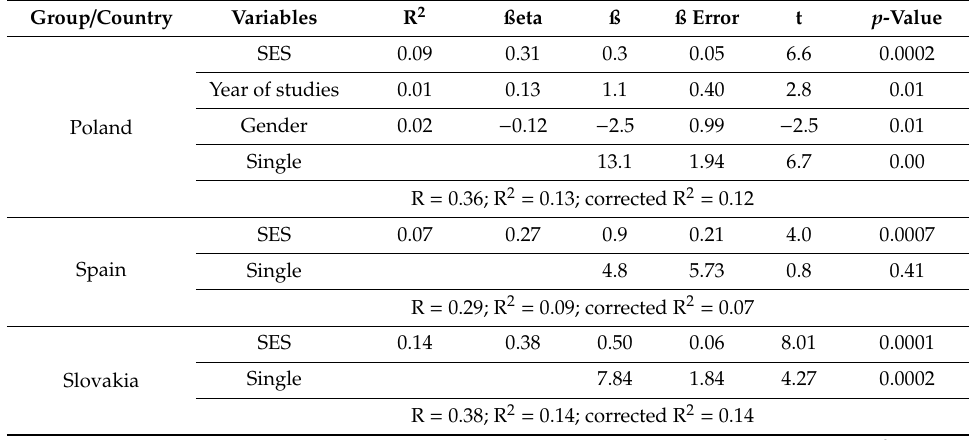
Table 3. Summary of regression—life satisfaction according to SWLS among nursing students. Group / Country Variables R 2